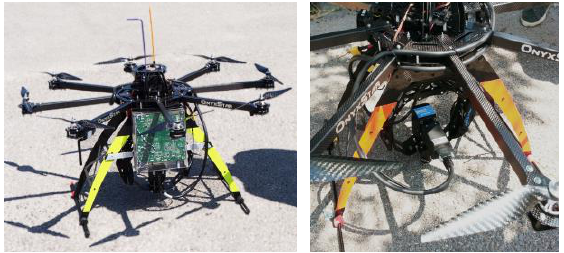
Figure 1. The multicopter equipped with the push-broom hyperspectral VNIR (380nm-1000nm) imaging